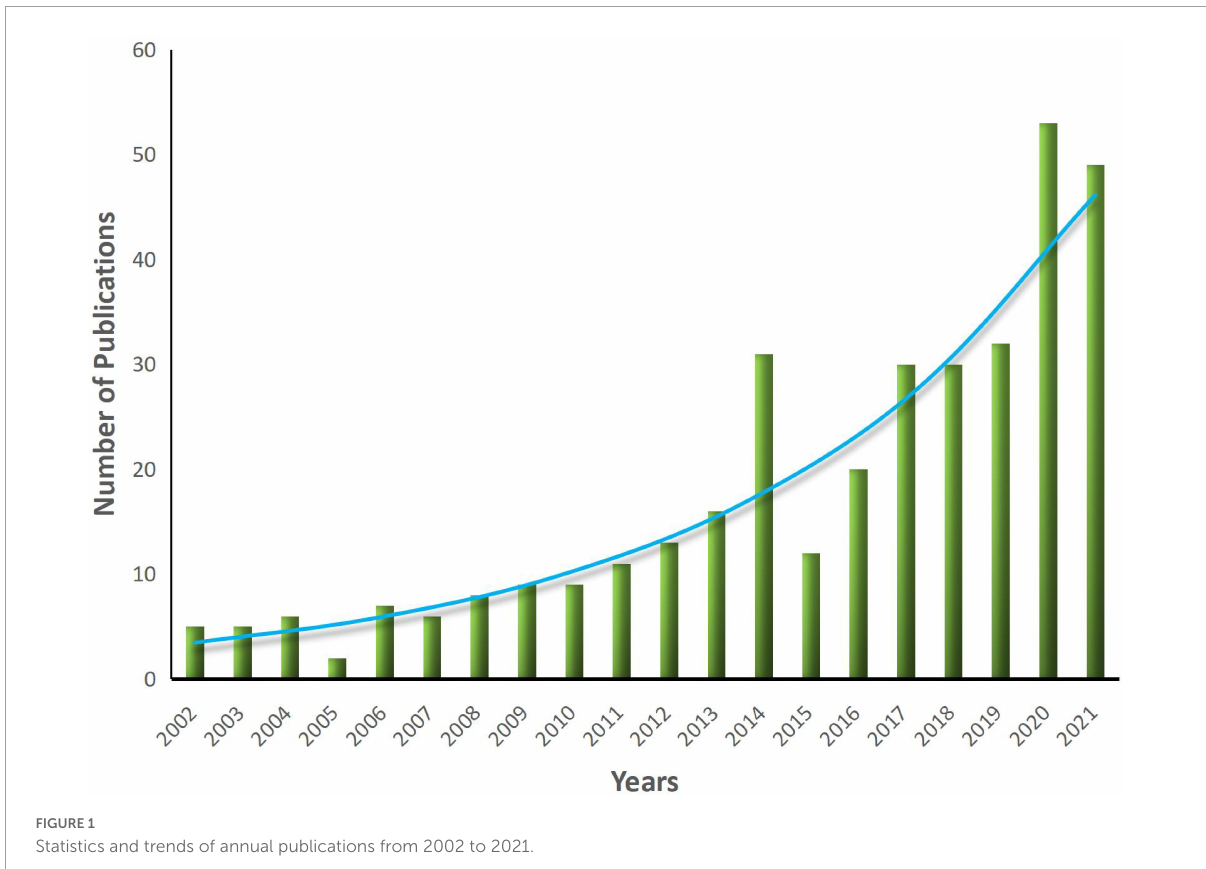
FIGURE1 Statistics and trends of annual publications from 2002 to 2021.